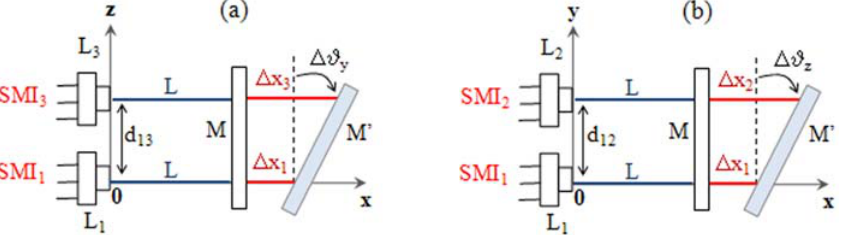
Figure 4. Schematic geometry of the setup for (a) pitch and (b) yaw measurement. Each interferometer SMI (i = 1,2,3) is made of a laser diode L and a plane mirror M. M’ is the i i position of the target after the roto-translation, and L is the distance of the target from the lens before the motion. The monitor photodiode, placed at the rear facet of the laser inside the laser package, and the converging lens have not be drawn in the scheme.